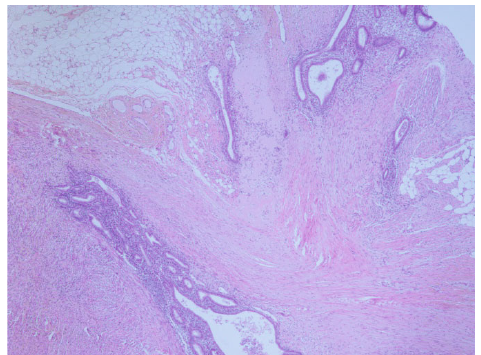
Figure 7: Endometrial glands and stroma within mesoappendix and wall (H&E, 4x).